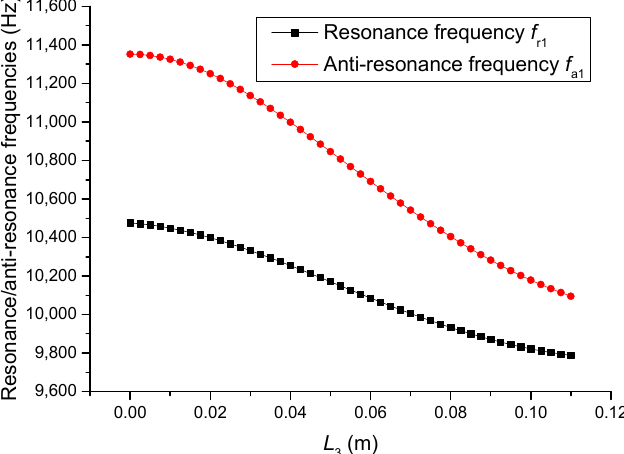
Figure 11. Theoretical relationships between the resonance/anti-resonance frequencies and length L 3 at the fundamental mode (Position effect of PZT-3).